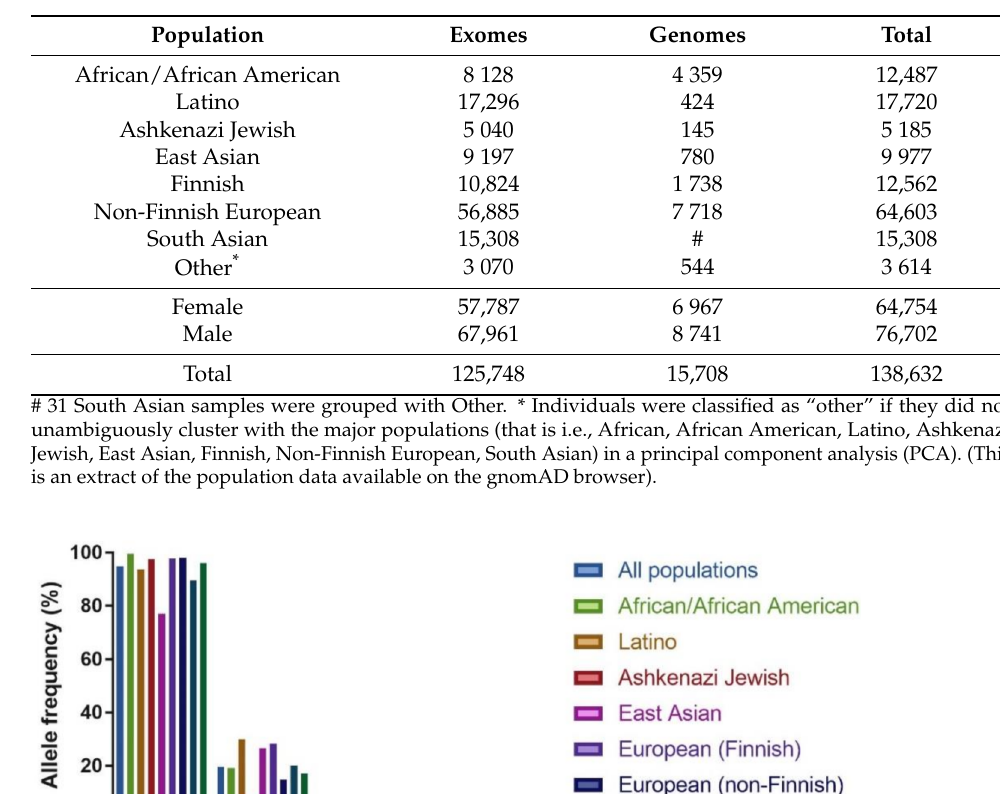
Table 1. Population data used in this study.